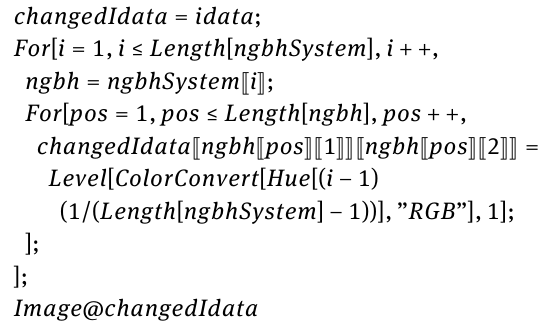
Algorithm 3: The algorithm visualizing the characterization of the iris